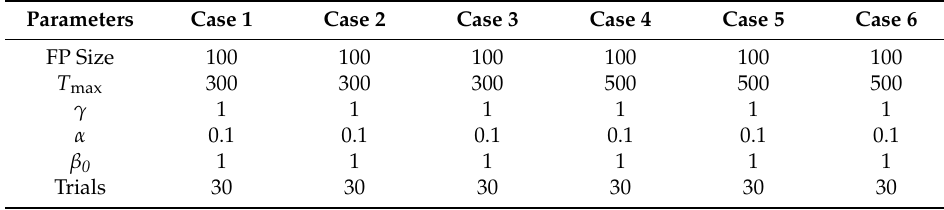
Table 4. Algorithm parameters of MOFA-CPA and MOFA-PFA for Cases